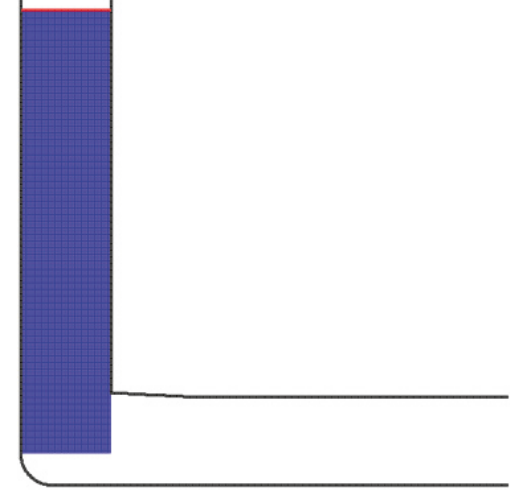
Figure 2: Equipment of ECAP.